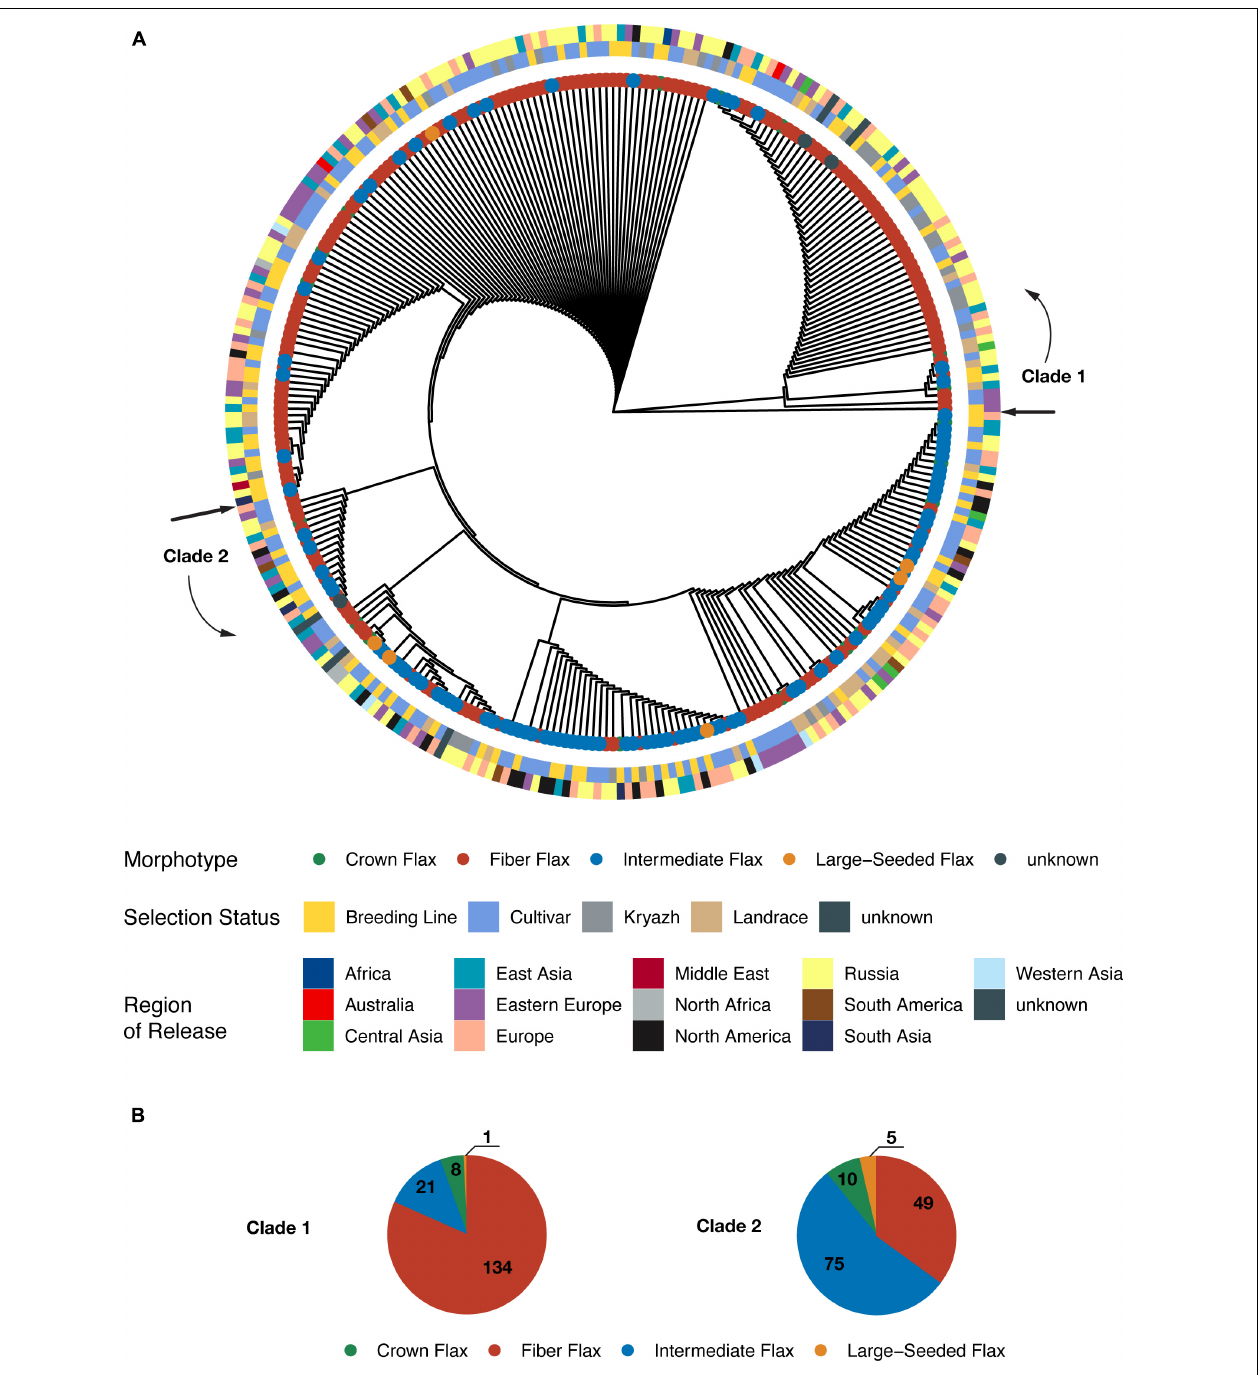
FIGURE 3 | A maximal likelihood phylogenetic tree constructed from genome-wide SNPs. (A) The circular cladogram. The outermost ring depicts distribution of accessions according to country or region of release. The next two rings show grouping of accessions with respect to selection status and morphotype, respectively. (B) Pie charts showing composition of the clades. Each slice represents a particular morphotype.